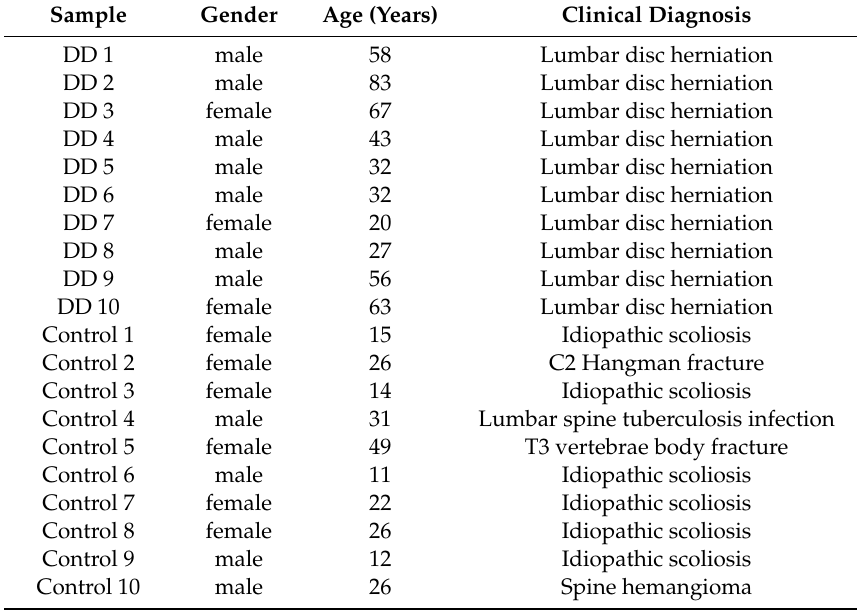
Table 1. Clinical information of the patients included in the study. DD 1–10: Disc Degeneration Group, diagnosed as lumbar disc herniation; Control 1–10: Control Group without disc